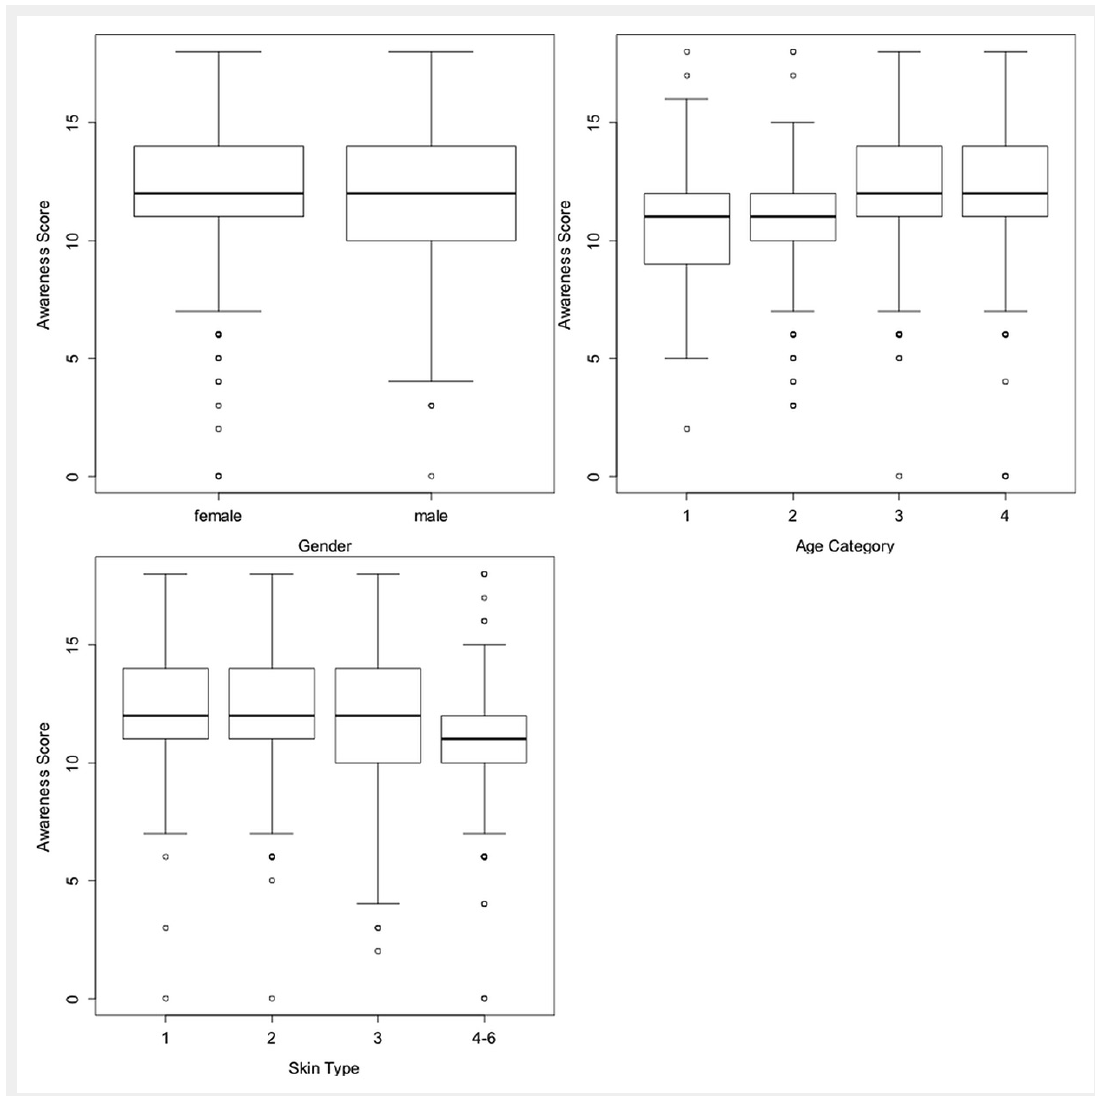
Figure 3 Box plots of the skin cancer awareness score and the gender, the age category and the skin type of the participants, univariate level. The correlation between the skin cancer awareness score and gender, age category, and skin type were statistically significant (for individual p- values refer to table 2). Four age categories were made, based on the year of birth of the athletes: category 1 (18–24 years), category 2 (25–34 years), category 3 (35–54 years) and category 4 (≥55 years). The skin type was divided into four different groups: Category 1 (Fitzpatrick skin type I), category 2 (Fitzpatrick skin type II), category 3 (Fitzpatrick skin type III) and category 4 (Fitzpatrick skin type